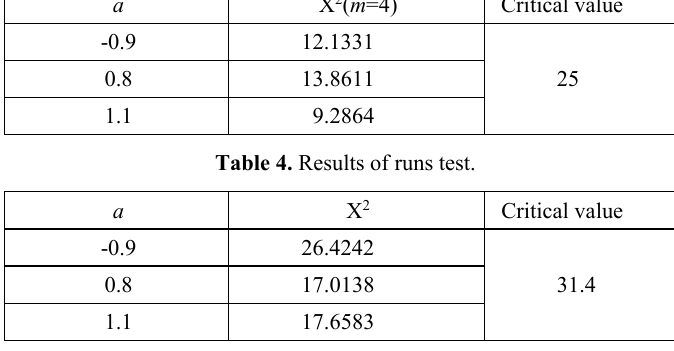
Table 5. Results of auto-correlation test.